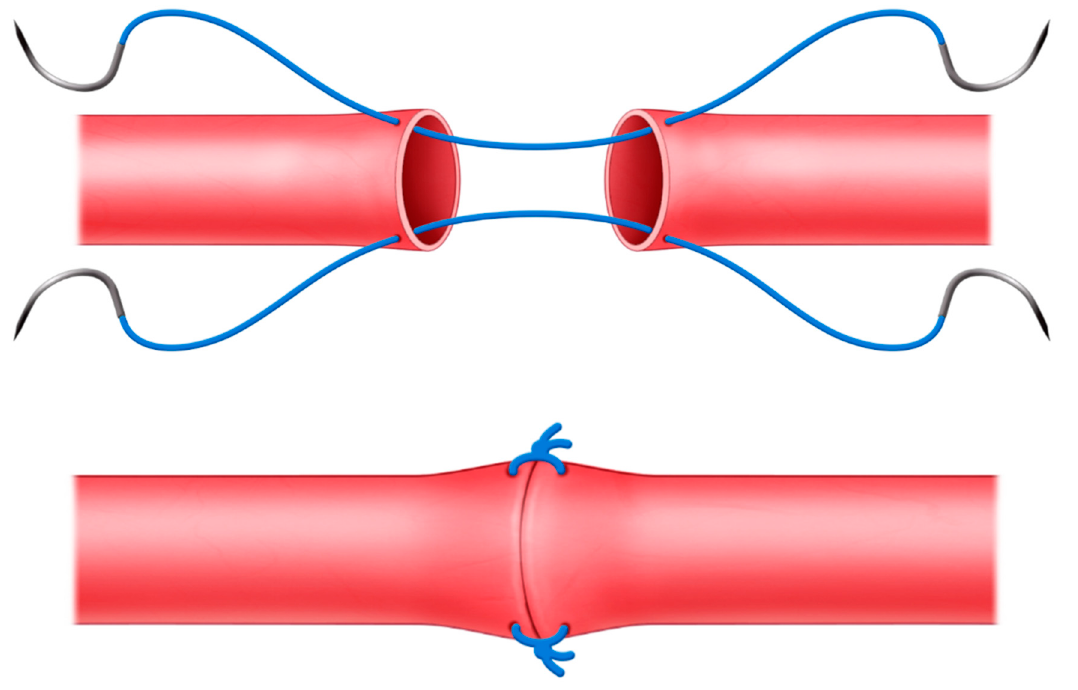
Figure 1. Schematic illustration of the 2-point suture technique.